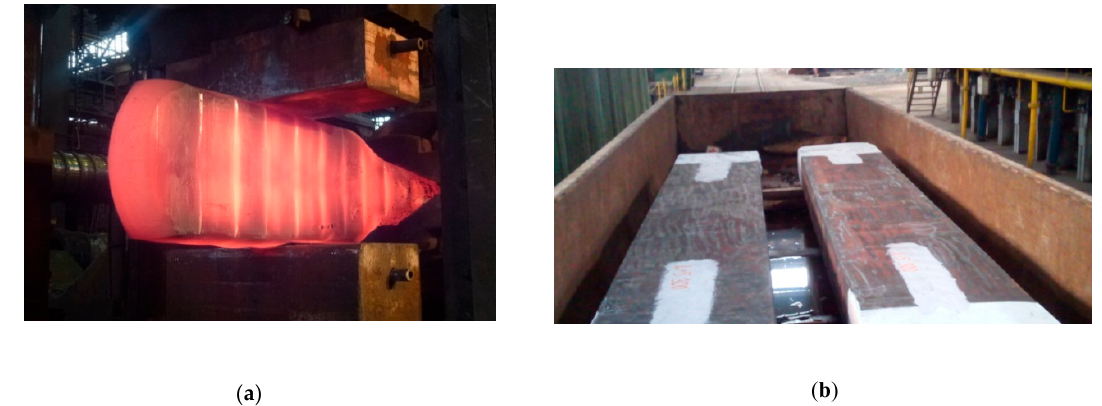
Figure 7. ( a ) Drawing operation in the forging of the plate from the P40N slab ingot; ( b ) forged plates from P40N slab ingot.